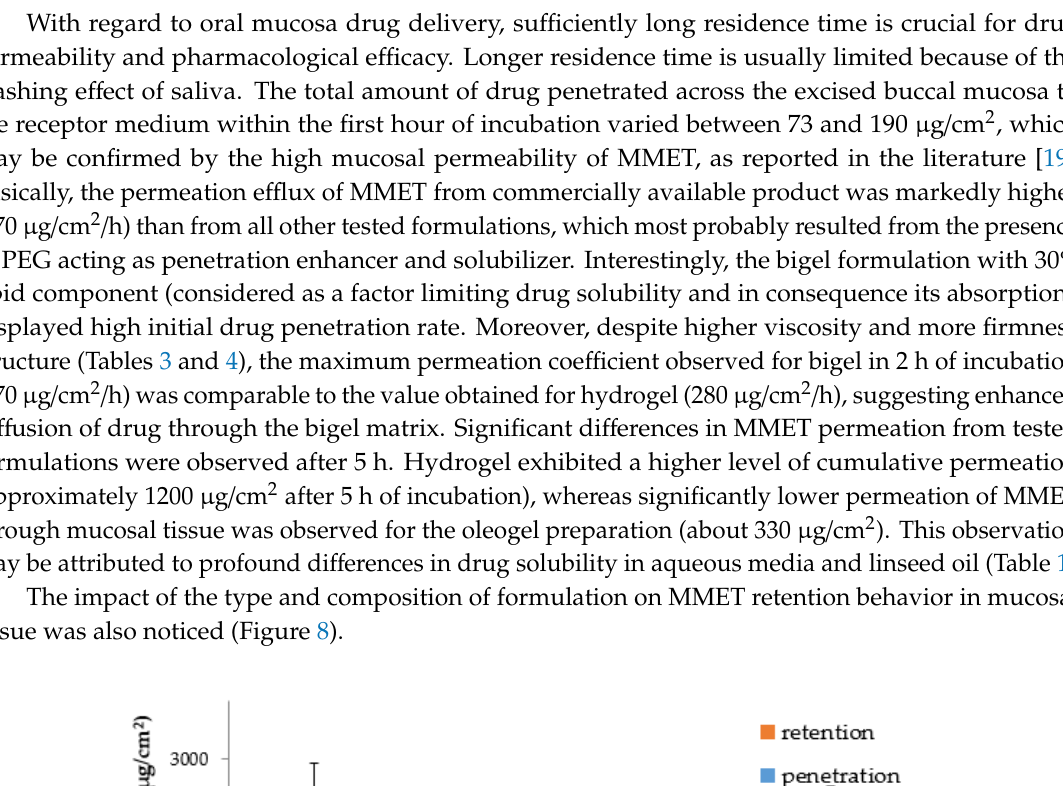
Figure 7. Penetration of MMET from hydrogel, oleogel and bigel formulations as compared to commercially available ointment with MET through porcine buccal mucosa (expressed as the amount of drug penetrated per unit of tissue area to acceptor medium).